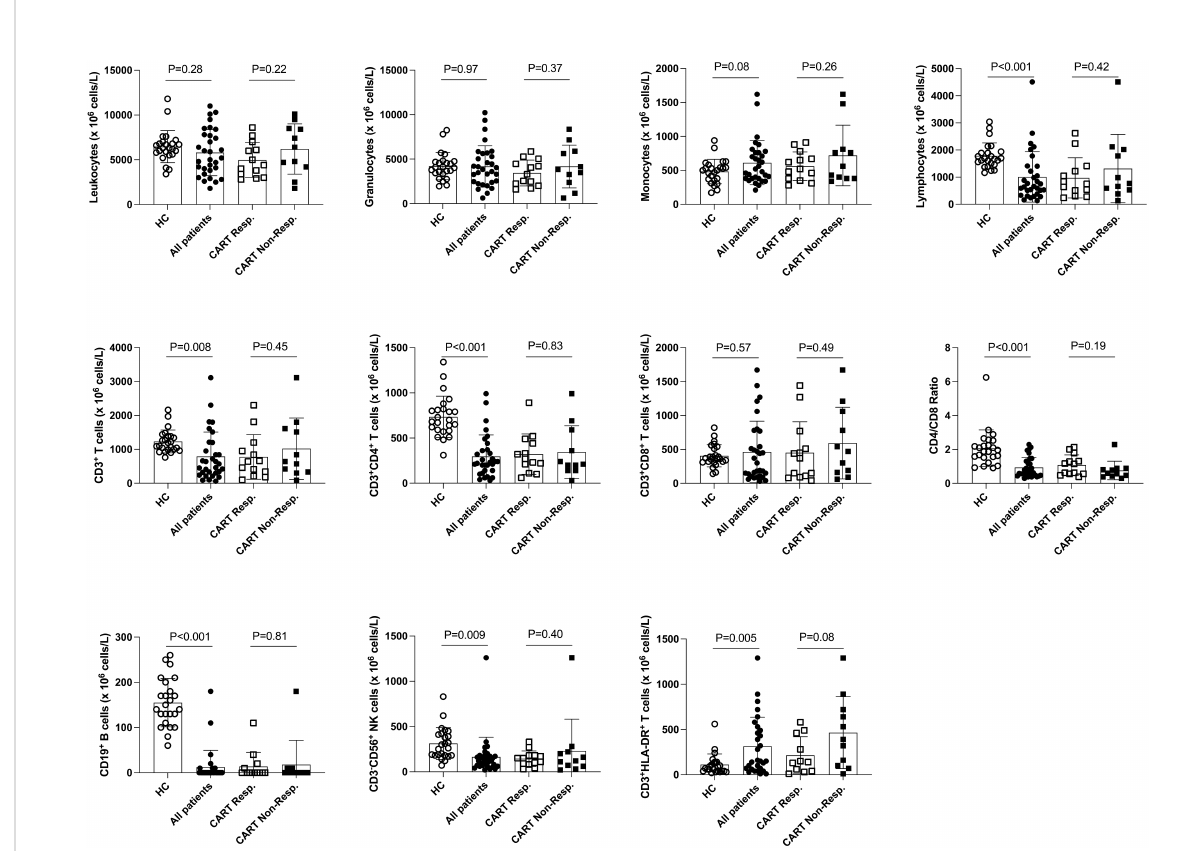
FIGURE 1 Distribution of leukocyte populations in the PB of healthy control subjects, total r/r DLBCL patients and CART cell recipients. Here, the distribution of PB cell populations of 24 healthy control subjects (HC) and 31 of 33* r/r DLBCL patients is shown. Data of 13 of 15* CART cell responders (except 11 for CD3 + HLA-DR + T cells) and 11 CART non-responders 3 months after CART therapy are shown separately. P-values (unpaired t-test) are indicated. *) PB of two patients belonging to the CART responders was not available for analyses at this